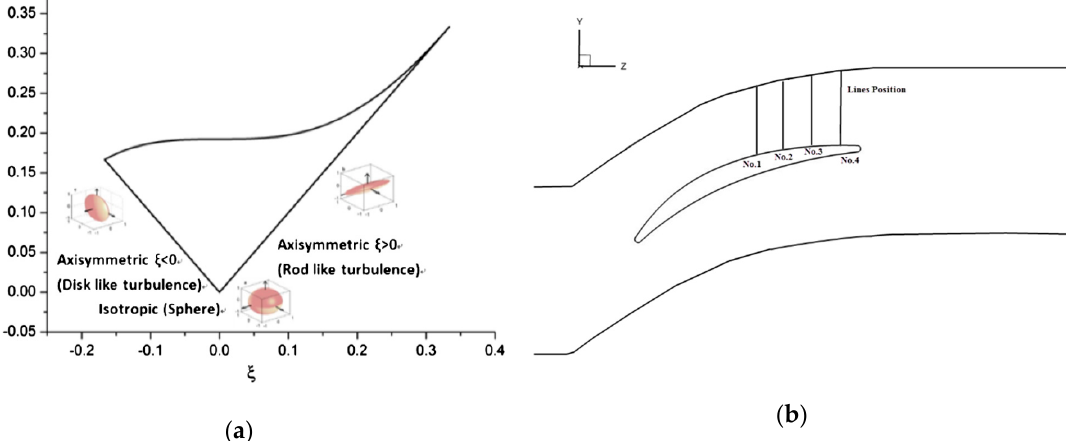
( f ) Figure 15. Reynolds stress throughout the blade passage: ( a ) <u’u’>; ( b ) <v’v’>; ( c ) <w’w’>; ( d ) <u’v’>; ( e ) <u’w’>; ( f ) <v’w’>. Lumley triangle theory [22] is used to further characterize the anisotropy of Reynolds stresses in the corner separation region. According to the real physical turbulence, the second and third order invariants of the non-dimension tensor b ij need to be solved in the triangle theory. The definition of b ij is as follows: